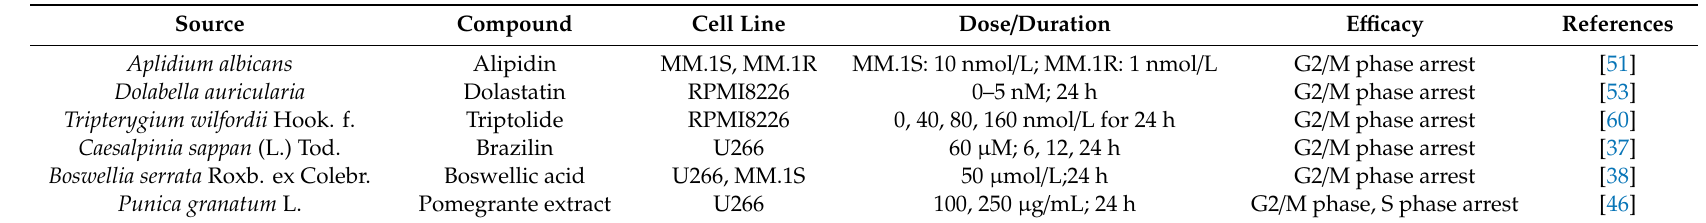
Table 4. Cell cycle arrest inducing natural